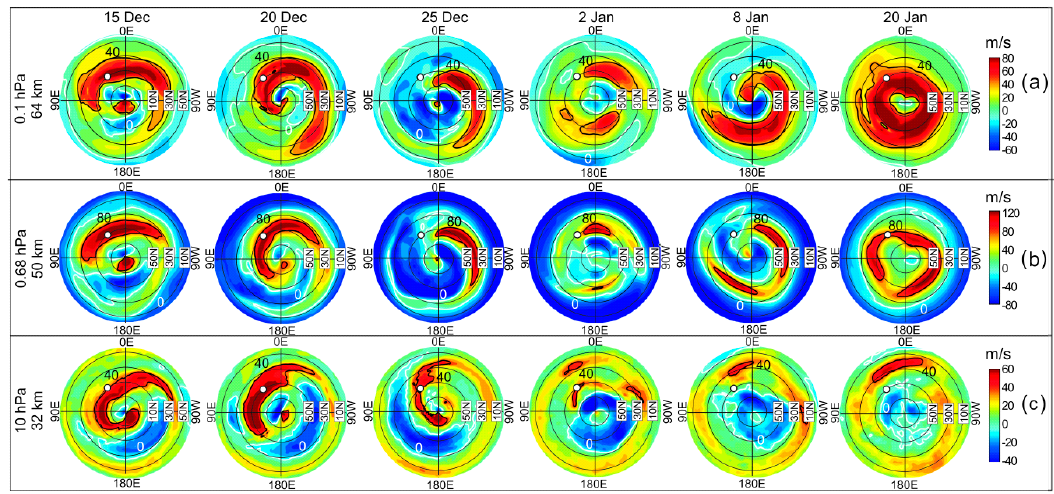
Figure 5. The zonal wind field over the NH (0–90°N) on selected dates between 15 December 2018 and 20 January 2019 from the ERA-Interim reanalysis [40]: ( a ) At the lower mesosphere (64 km); ( b ) stratopause (50 km); and ( c ) middle stratosphere (32 km) levels before (15, 20, and 25 December 2018) and during (2, 8, and 20 January 2019) the SSW2 event. The white circle shows location of the MWR site Kharkiv relative to the westerly maximum marked by the black contours. The white contour corresponds to zero zonal wind.